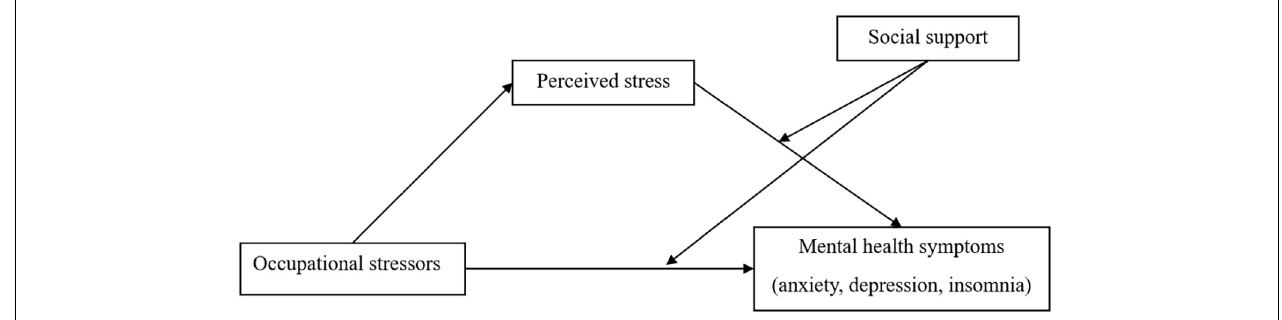
FIGURE 1 | The moderated mediation effect among occupational stressors, mental health symptoms (anxiety, depression, and insomnia), perceived stress, and social support.